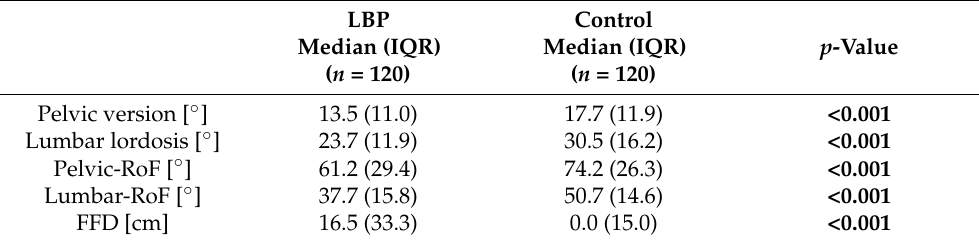
Table 3. Differences in pelvic version and lumbar lordosis, as well as pelvic- and lumbar-RoF, between matched LBP participants and the control